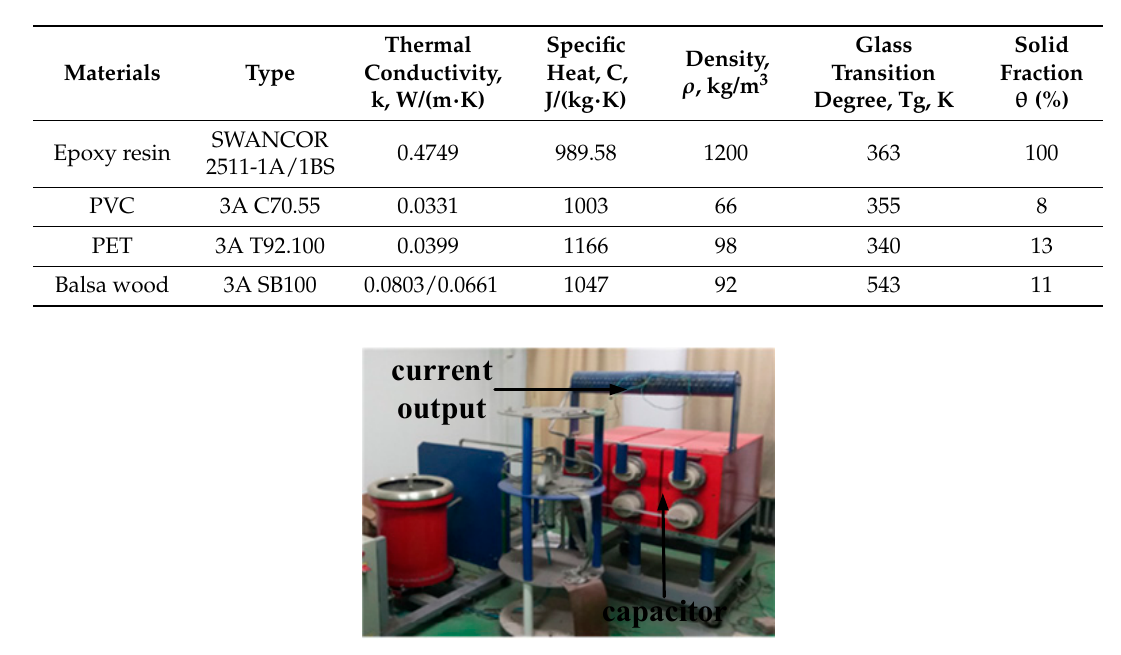
Table 1. Material parameters.